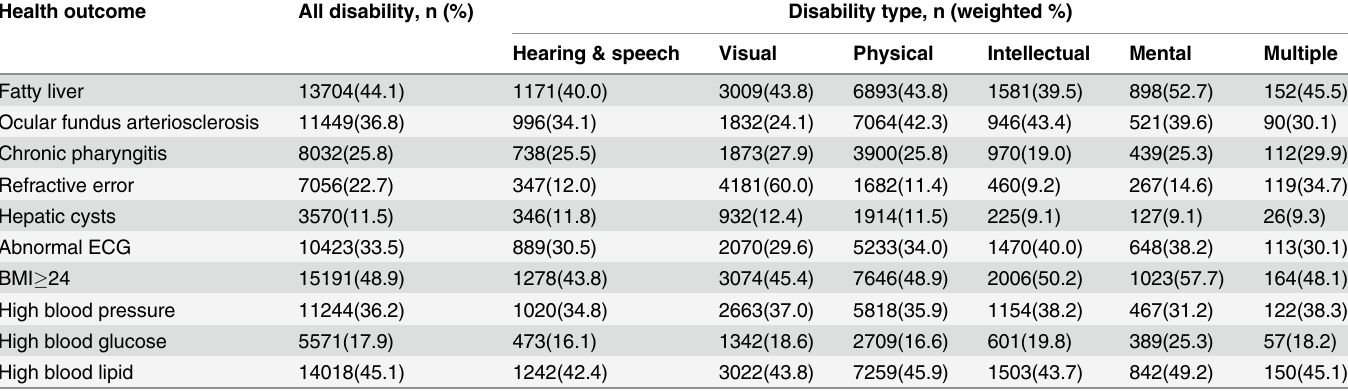
Table 2. Health conditions among each disability type.